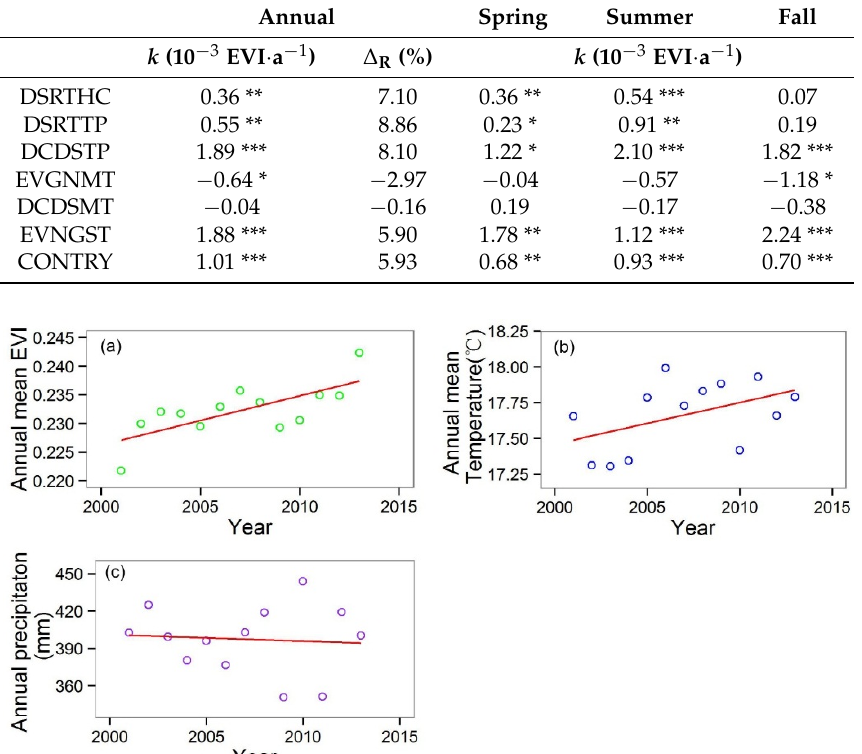
Table 2. Temporal trends in annual and seasonal EVI based on the Generalized Least Squares Regression. k denotes Linear coefficient for year. ∆ R is the relative change computed as the slope k in the second column times 13 then divided by the annual average EVI in 2001. CONTRY denotes the pooled EVI of the countrywide shrublands; p values were based on one-tailed hypothesis, and “*”, “**”, and “***” are for p -values less than 0.1, 0.05, and 0.01, respectively. Annual Spring